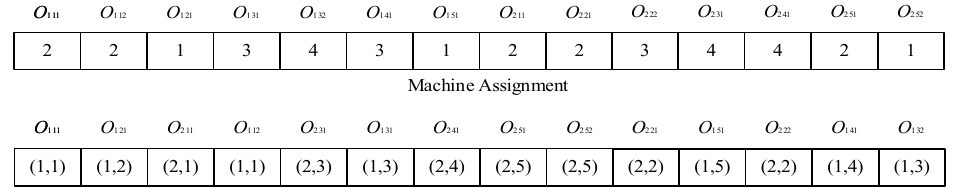
Permutation(1,1) Permutation(1,1) Operation Operation Figure 2. The encoding scheme. Figure 2. The encoding scheme. Figure 2. The encoding scheme.